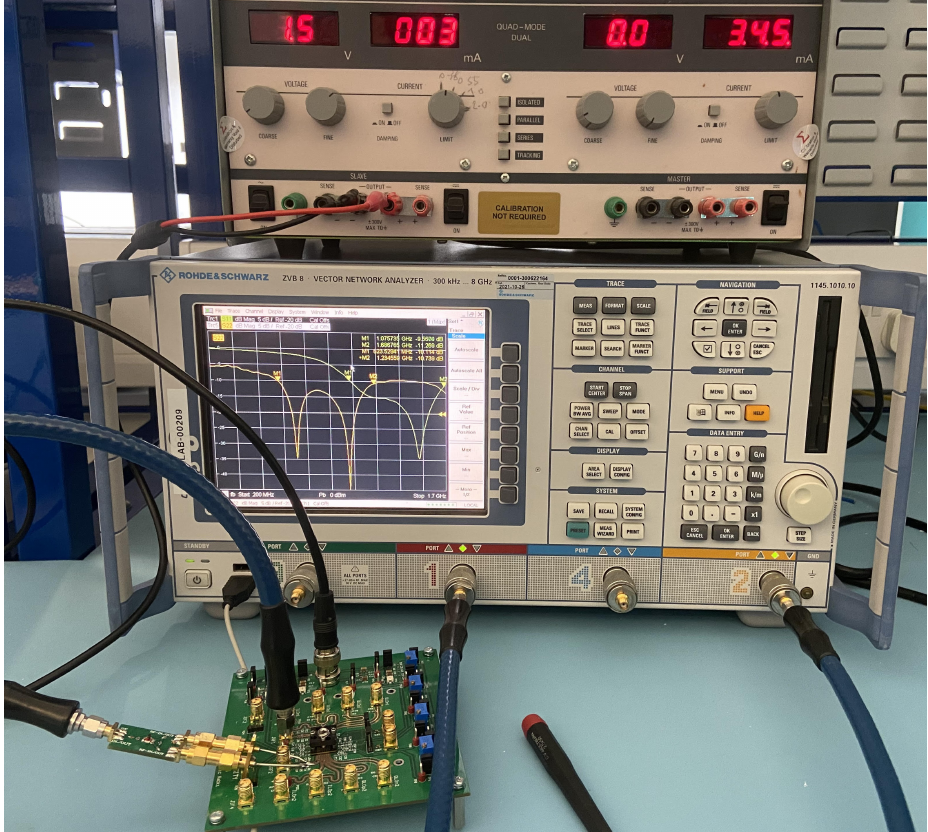
Figure 7. Measurement setup using a VNA to evaluate the S 11 performance of CRR1 and CRR2. The voltage shown on the power supply is applied to the LDO on the PCB that in turn provides the 1.2 V supply to the